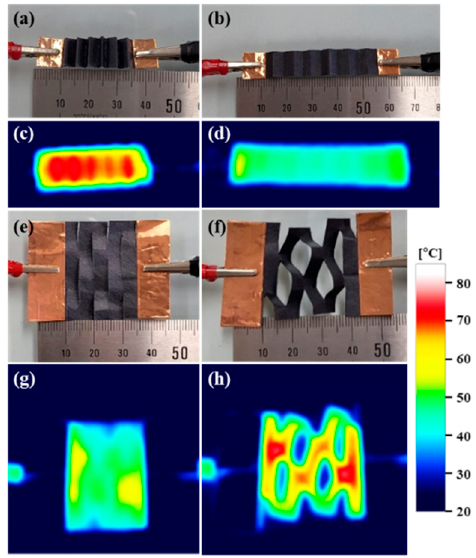
Figure 8. Image of stretchable structure under a Joule heating system. ( a ) Folding state, ( b ) unfolding state, ( e ) Kirigami patterning achieved by a simple cutting method, ( f ) stretching state by the Kirigami structure. Investigation of thermal distribution by thermal imaging camera of ( c ) folding state, ( d ) unfolding state, ( g ) Kirigami pattern, ( h ) stretching state of the Kirigami structure.